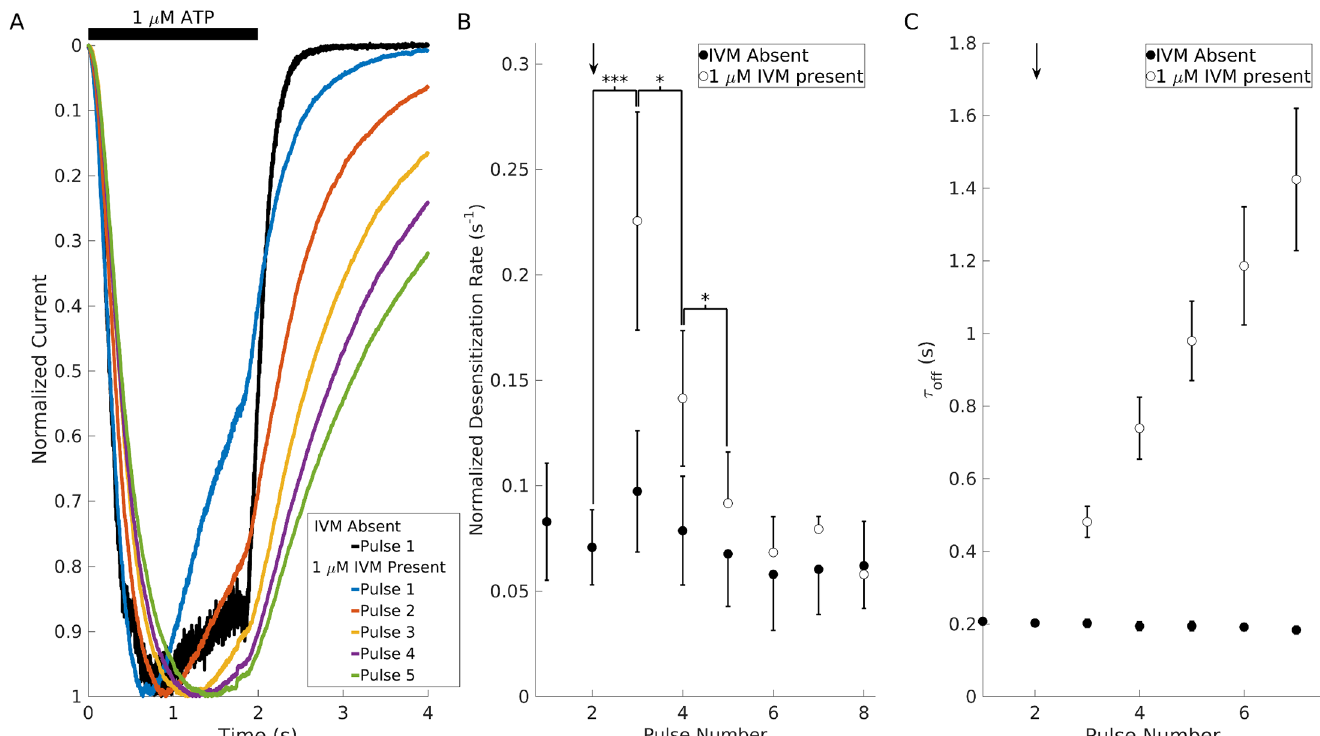
Fig 1. Effect of IVM on desensitization and deactivation kinetics in rat P2X4R. (A) Superimposed current pulses inducedby 1 μ M ATP and normalized by their maximum amplitudes, highlighting receptor kinetics duringthe pulse protocol(ATP applicationis highlightedby the black bar above the traces) performed with 1 μ M IVM (derivedfrom [20]). (B) Desensitization rates determinedby linear fitting of the desensitization phase of each current pulse. In the absenceof IVM (full circles), there was no significantvariation in the desensitization rate, but following1 μ M IVM application(arrow), the desensitization rate significantly increased, followedby a gradualdeclineback to its value prior to stimulationwith IVM. Statistical significance was calculatedwith the one sided Wilcoxon signed rank test. * p < 0.05; *** p < 0.005. (C) In the absenceof IVM (full circles), deactivationkinetics remained constant after repeatedagonist applications. In the presenceof IVM (open circles), deactivationkinetics progressively sloweddown with time. In A and B, data shown are means ± SEM from n = 7 records.